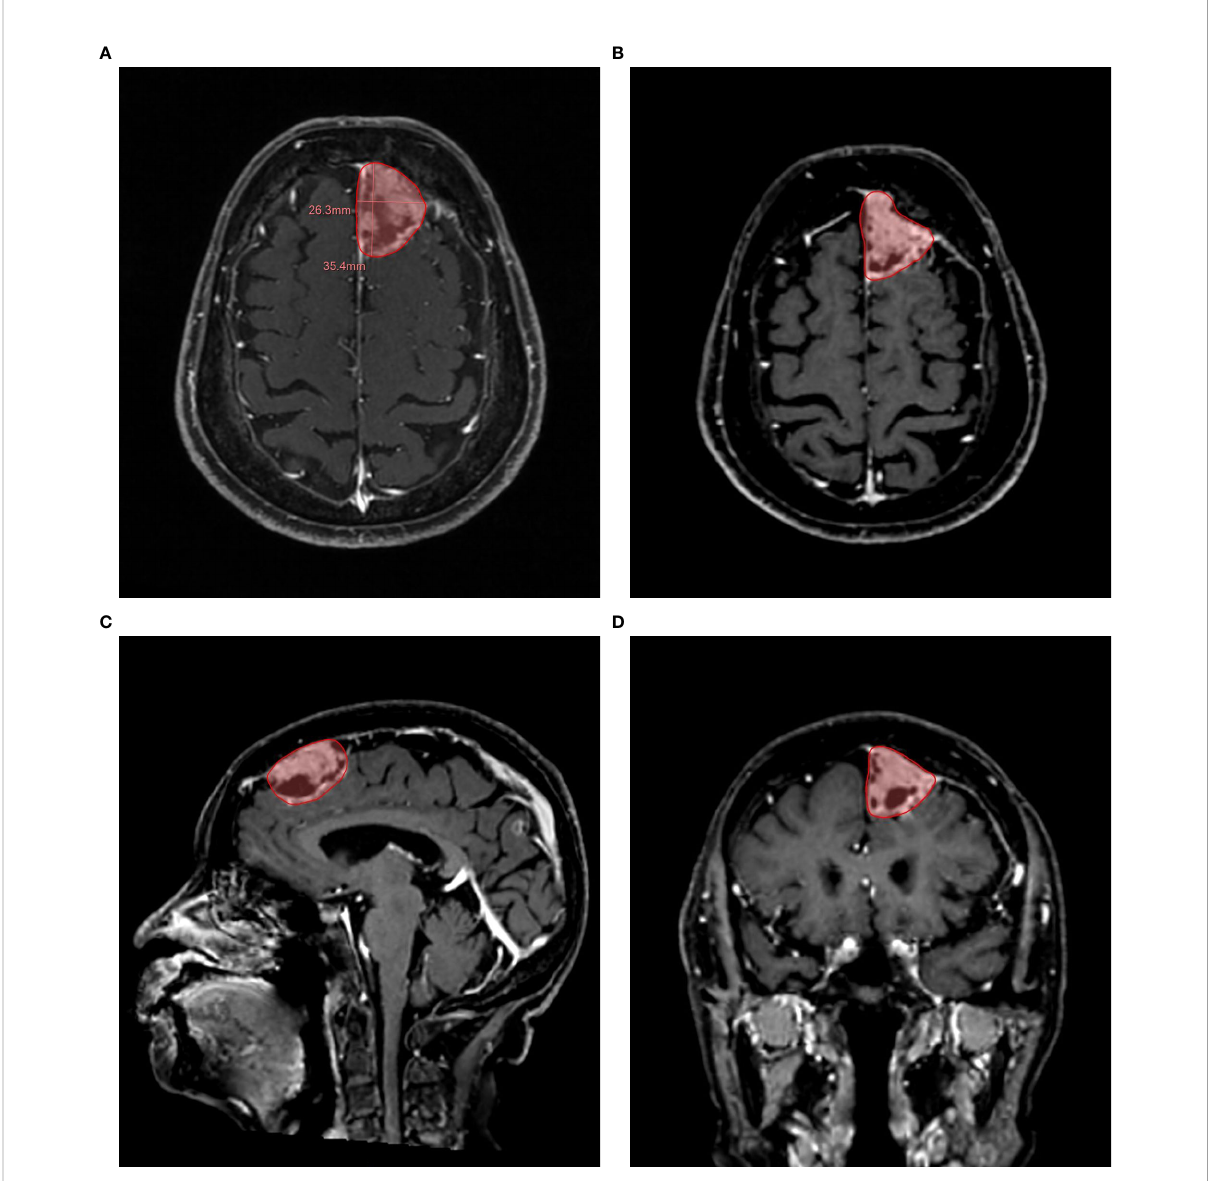
FIGURE 2 Example of a semi-automatic segmentation. The follow-up 3D CE-MRI of an 84-year-old female patient with brain metastases from lung adenocarcinoma. (A) : Automatic measurement of maximum long diameter and maximum axial diameter. (B) : Semi-automatic segmentation in axial plane. (C) : Semi-automatic segmentation in sagittal plane. (D) : Semi-automatic segmentation in coronal